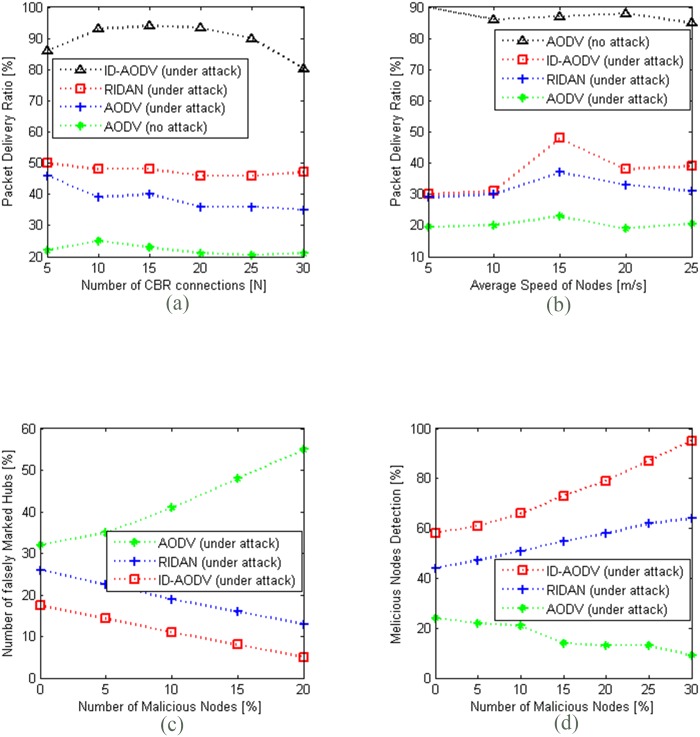
Under packet dropping attack: (a) Impact of number of CBR connections on packet delivery ratio, (b) Impact of average speed of nodes on packet delivery ratio, (c) Impact of percentage of malicious nodes on number of falsely marked hubs, (d) Impact of percentage of malicious nodes on malicious node detection.